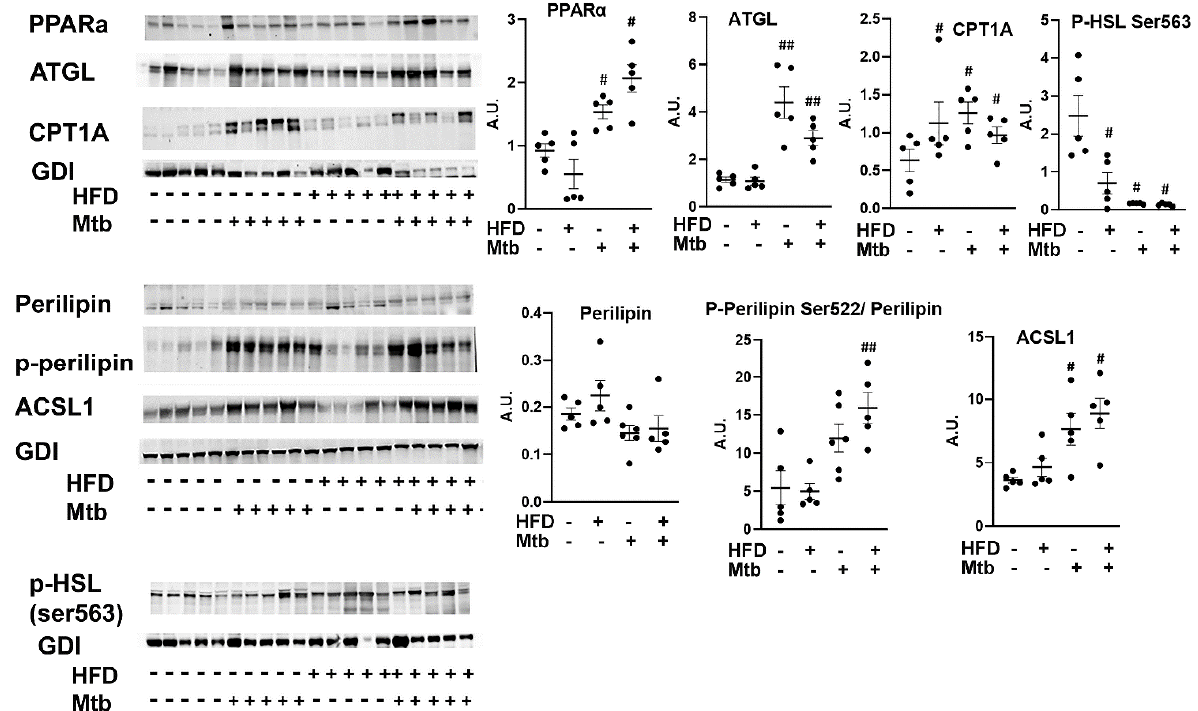
Figure 10. Mtb infection affects lipid metabolism in the lungs of adult mice. Immunoblot analysis of the levels of markers of lipid degradation and oxidation (PPAR α , p-Perilipin Ser522, Perilipin), lipases (p-HSL and ATGL), long-chain acyl-CoA synthetase (ACSL1) and CPT1 in lung lysates of infected and uninfected adult mice. GDI was used as loading control. Fold changes in the protein levels were normalized to GDI expression and are represented as a dot plot. The error bars represent standard error of the mean. # p < 0.05, and ## p < 0.01 compared to uninfected RD mice ( n = 5/group).